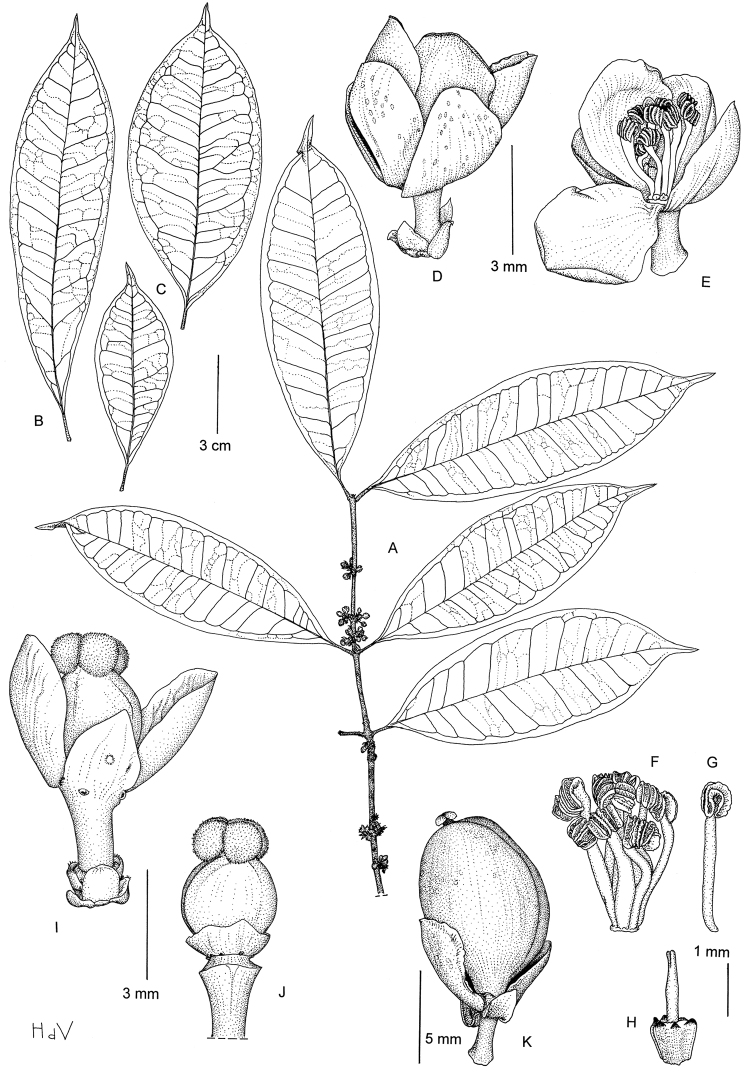
Garcinia gabonensis: A Flowering twig B, C Leaves, showing the variation D Male flower E Idem, open and three petals removed F Androecium G Stamen H Pistillode I Female flower J Gynoecium and disk K Fruit. (A, D–H: Leeuwenberg & Persoon 13683; B, K: Arends et al. 510; C, I, J: Wieringa et al. 4546). Drawing by Hans de Vries, NCB Naturalis (section NHN) ©.